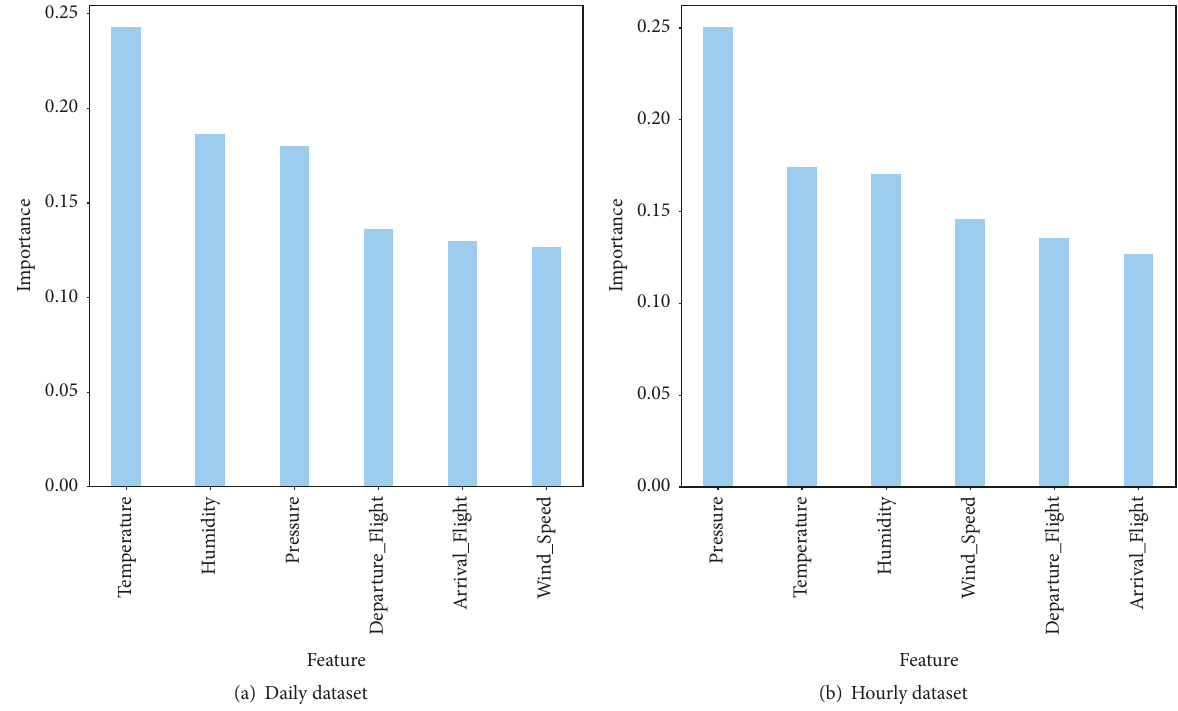
Figure 8: Feature importance for air quality